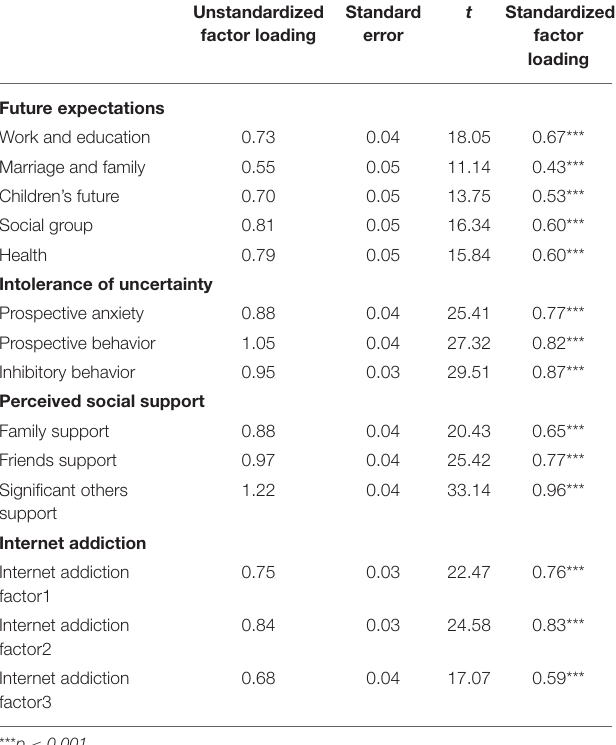
TABLE 3 | Correlation coefficients of latent variables.